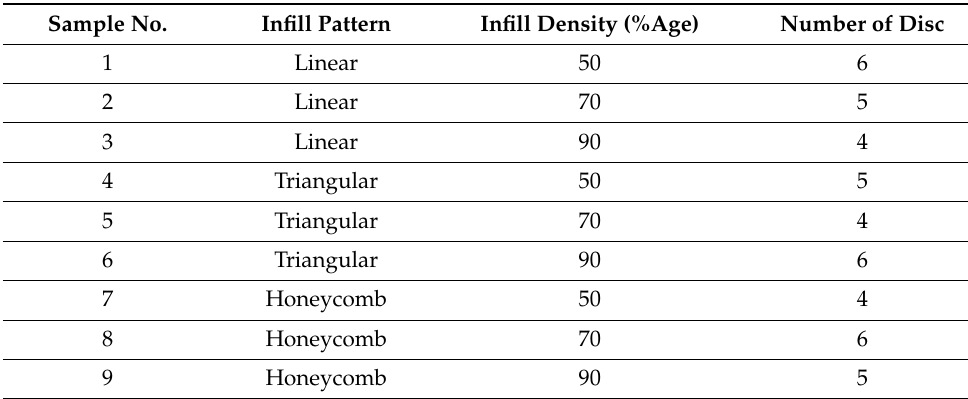
Table 2. DOE using Taguchi L9 OA for LOM of PLA material matrix. Sample No.